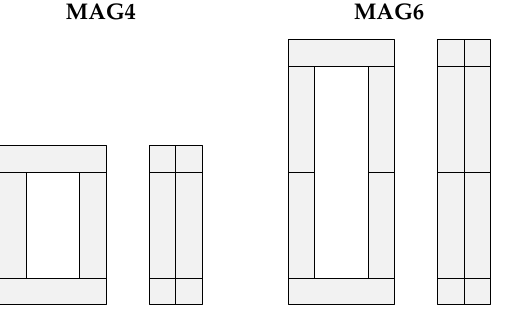
Figure A2. Single-phase multi air gap MFT core assembly: MFT4 with 4 air gaps ( left ) and MFT6 with 6 air gaps ( right ).